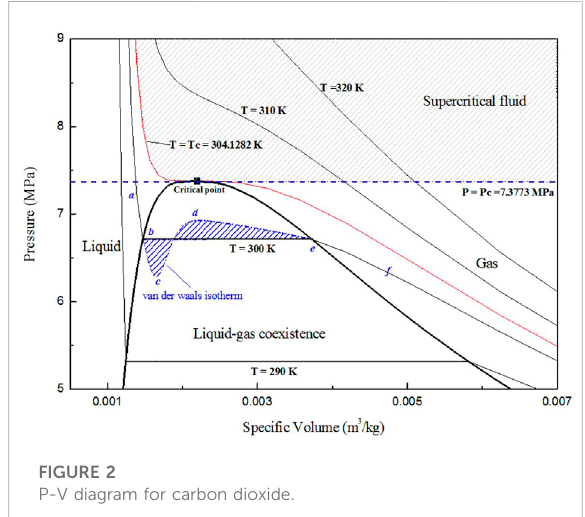
FIGURE 2 P-V diagram for carbon